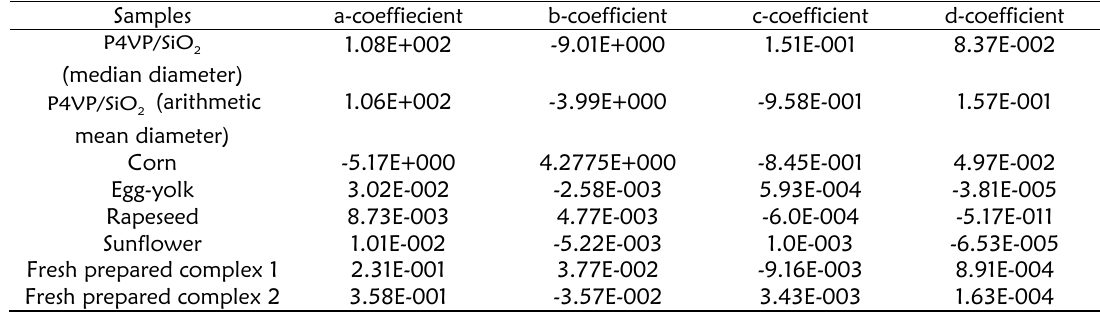
Table 4: List of various a, b, c and d coefficients for eq (8) and the data obtained from [20, 26, 27].